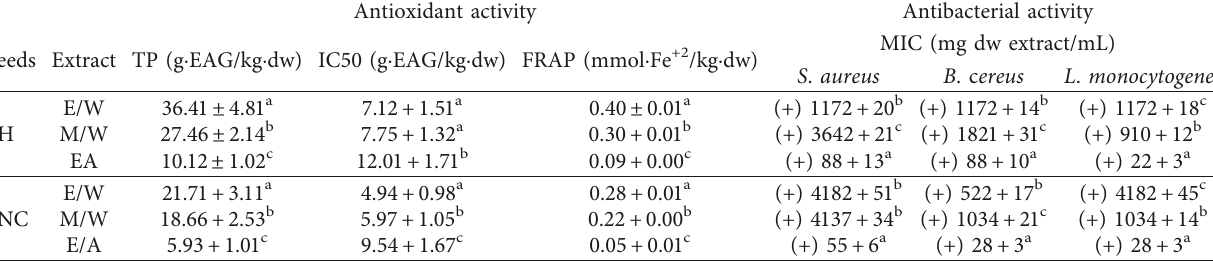
Table 3: DPPH (IC50), FRAP antioxidant assay, inhibition positive (+), and minimum inhibitory concentration (MIC) of bacterial development of SH and SNC